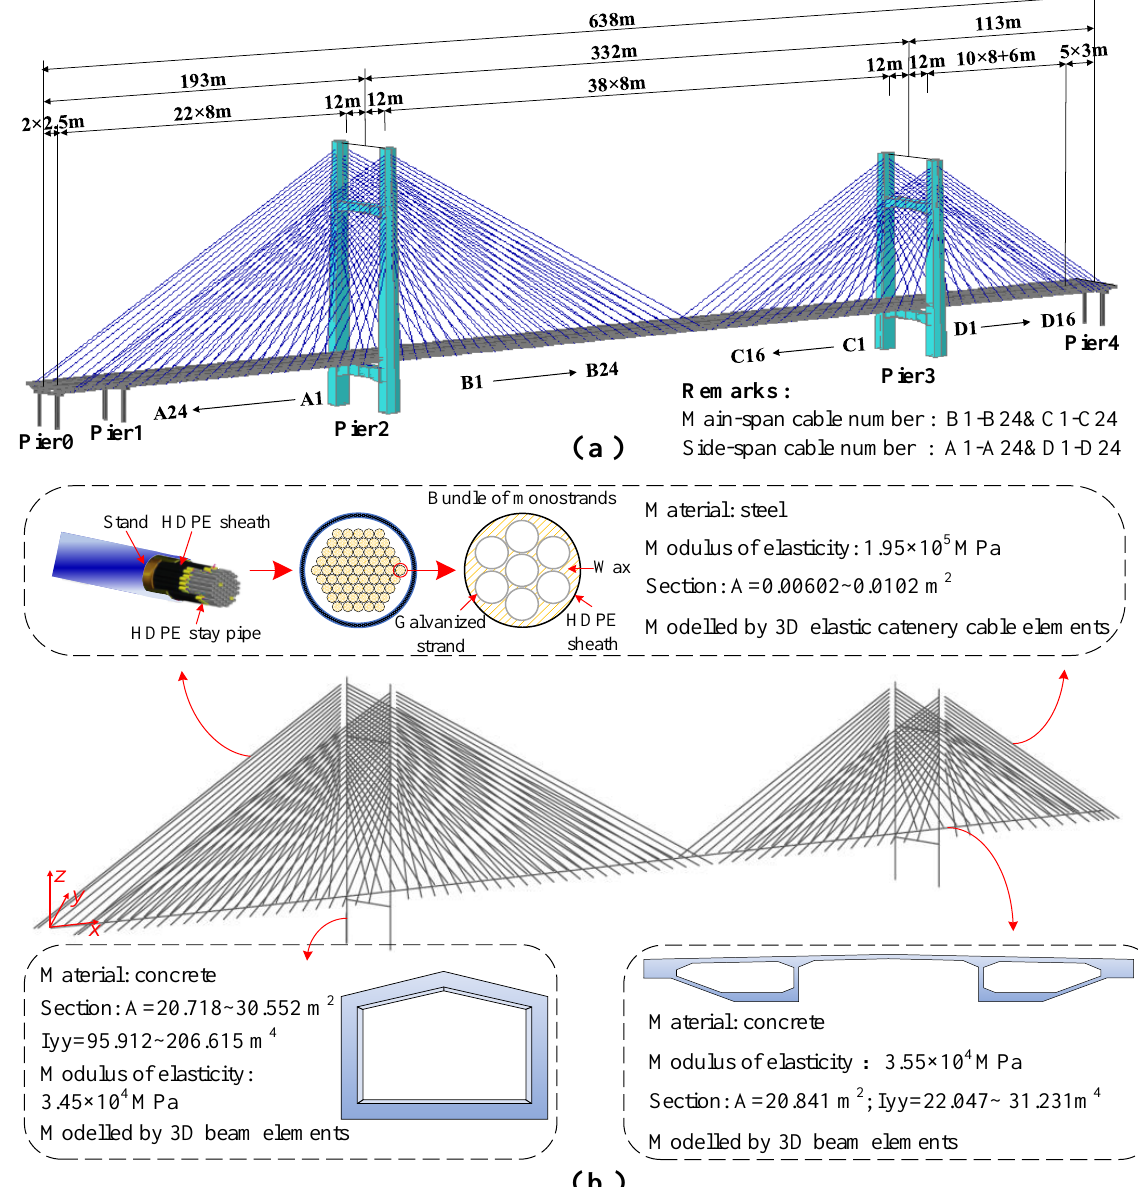
Figure 9. Description of the Yongjiang Bridge. ( a ) Yongjiang Bridge and ( b ) spatial FEM.